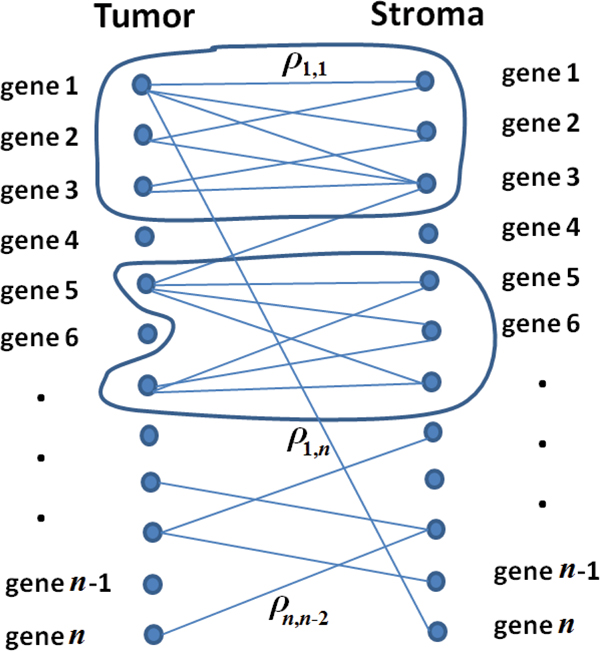
Bipartite graph of the tissue-tissue network. An illustration of the formulation of the tissue-tissue network as a weighted bipartite graph. For clarity of the figure, we do not show all the edges. Bipartite sub-networks in the two circles are examples of BiNets.